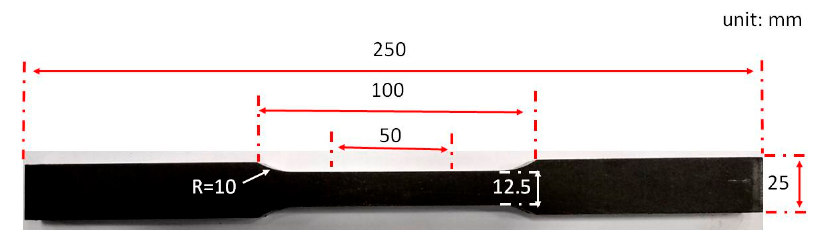
Figure 4. Schema of the flat tensile specimen.